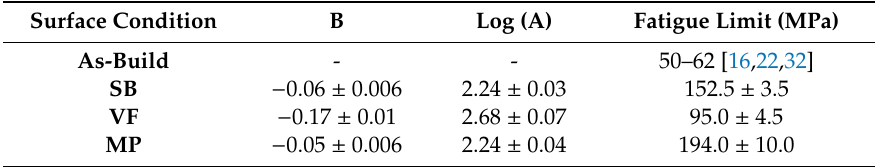
Figure 10. Effect of surface condition on fatigue curves of the L-PBF AlSi10Mg alloy. Table 5. Calculated fatigue limits and fitting parameters according to Basquin’s equation for the different surface conditions of the L-PBF AlSi10Mg alloy.